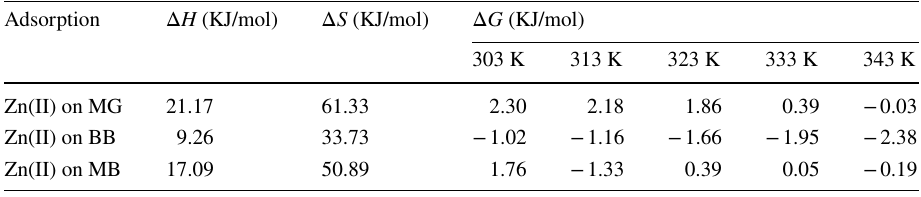
Fig. 12 Quantity of Zn(II) adsorbed ( q e ) onto a MG versus desorption steps for various concentrations of HCl, b BB versus desorption steps for various concentrations of HCl, c MB versus desorption steps for various concentrations of